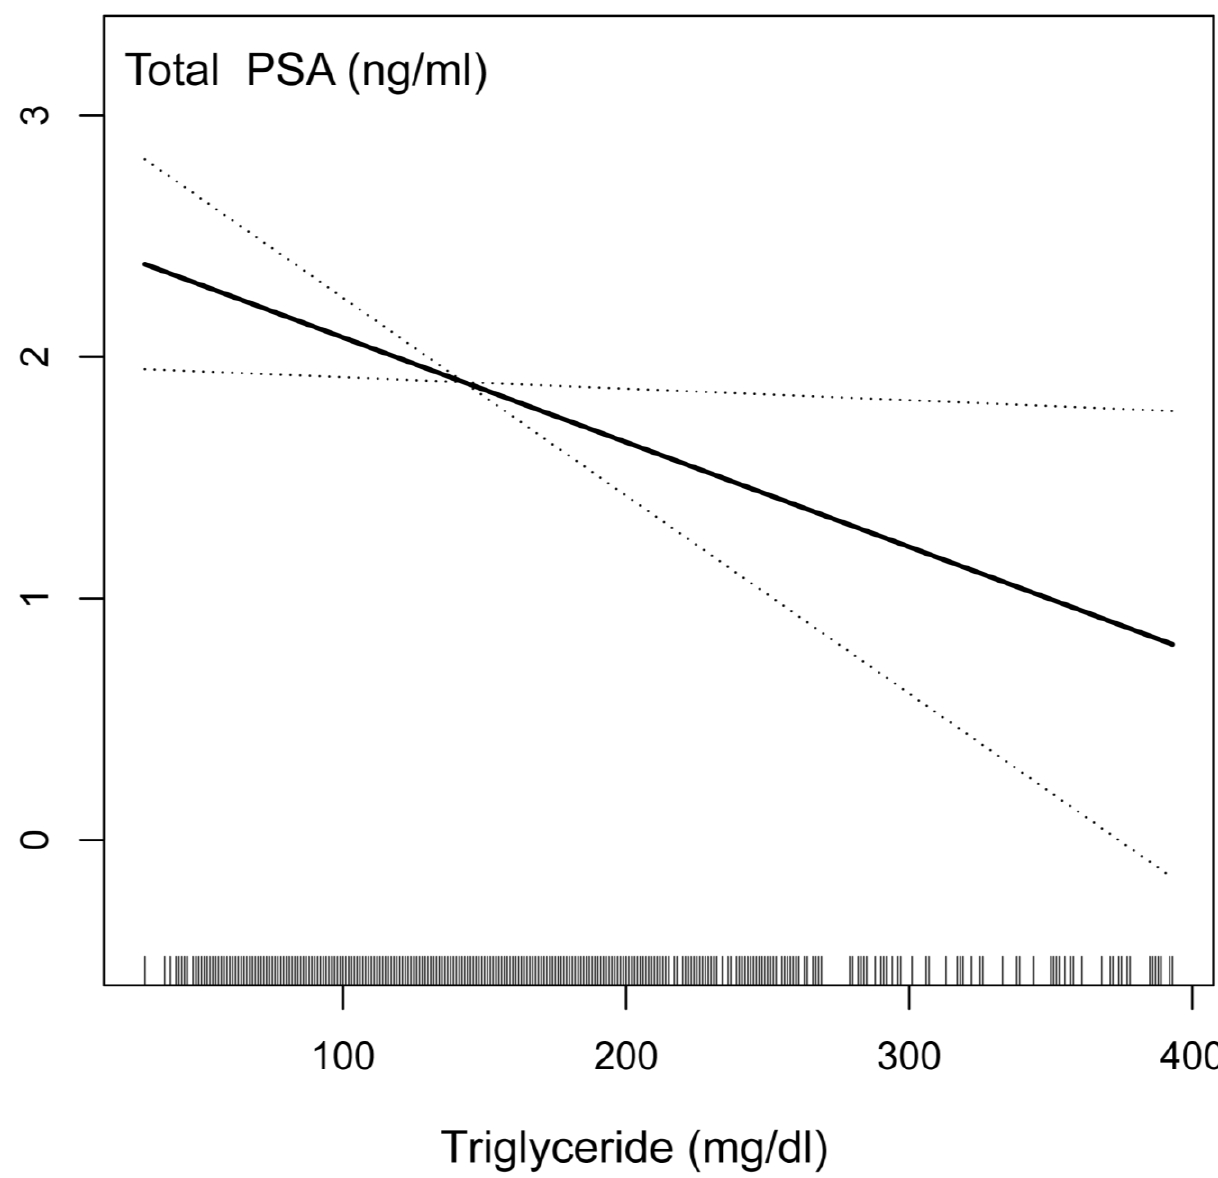
Figure 3. The relationship between serum triglyceride and prostate-specific antigen (PSA) connec-